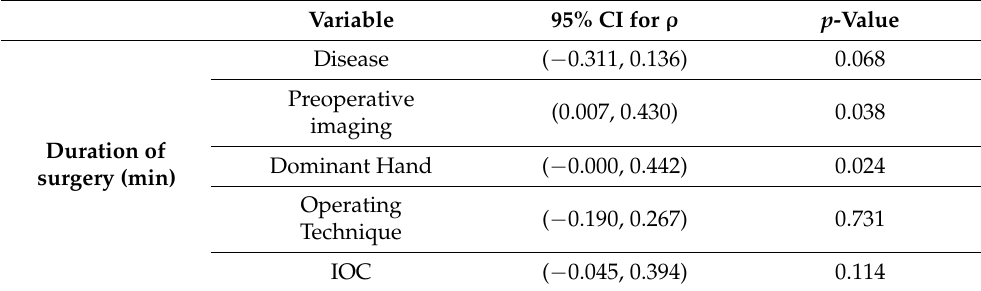
Table 6. Association between duration of surgery/postoperative stay and endpoints.